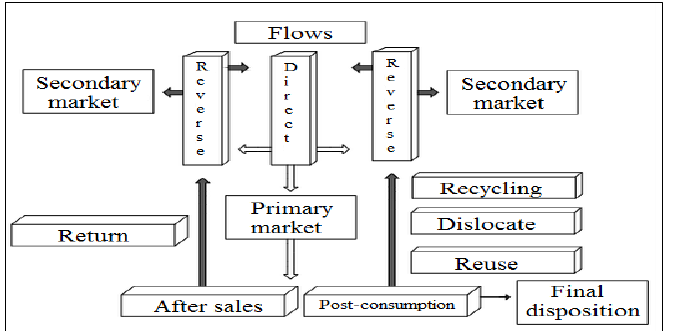
Figure 1: Direct and reverse distribution channels.